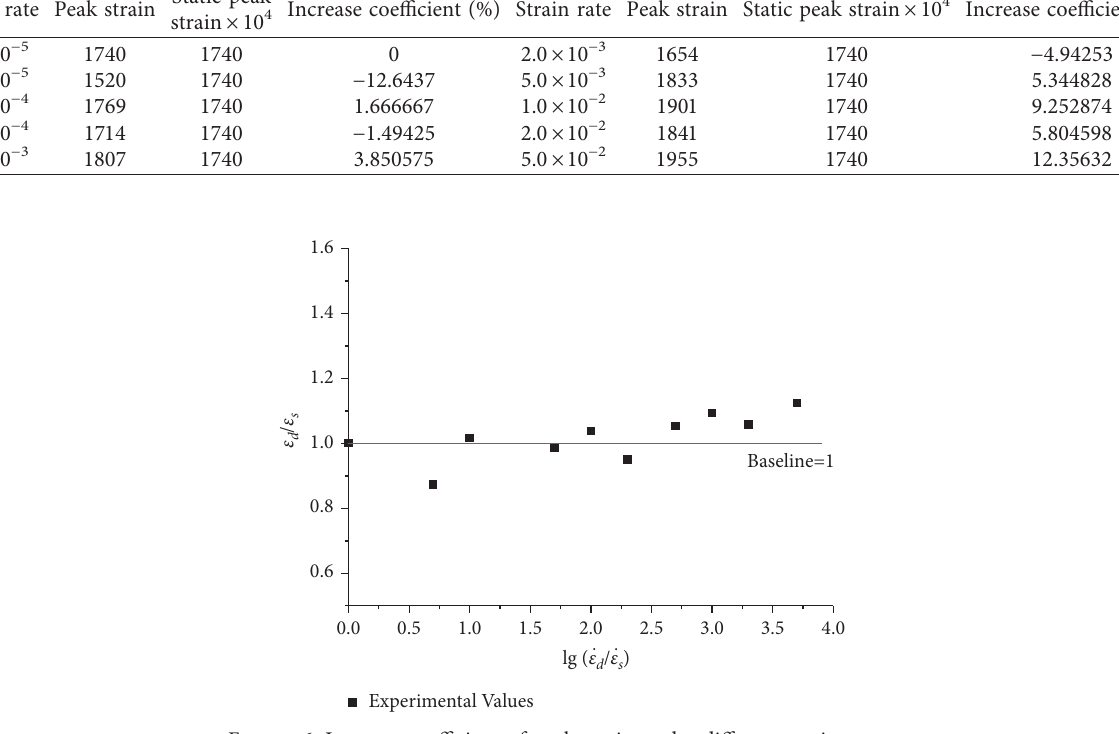
Figure 6: Increase coefficient of peak strain under different strain